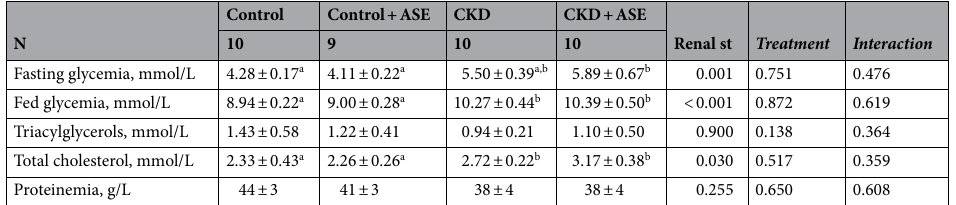
Table 2. Biochemical data of experimental mice. Data are expressed as mean ± SD. Significant differences were determined by ANOVA followed by Tukey’s multiple comparison tests. Different letters indicate a significant